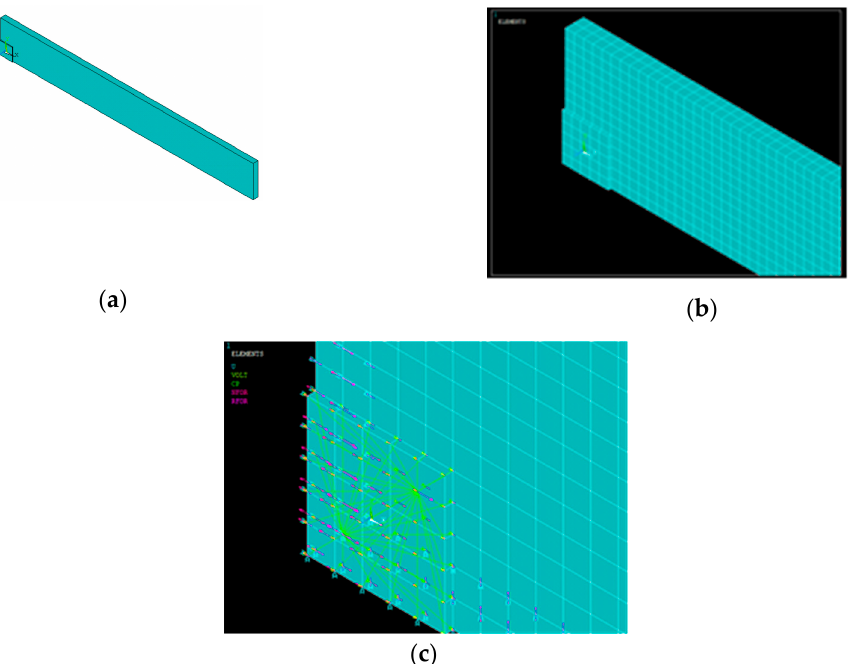
Figure 11. ( a ) 1/4th modeling of the aluminum block with PZT patch, ( b ) meshing of the model, ( c ) coupling effect. Table 2. Properties of test specimen (aluminum beam at ambient temperature 27 °C).